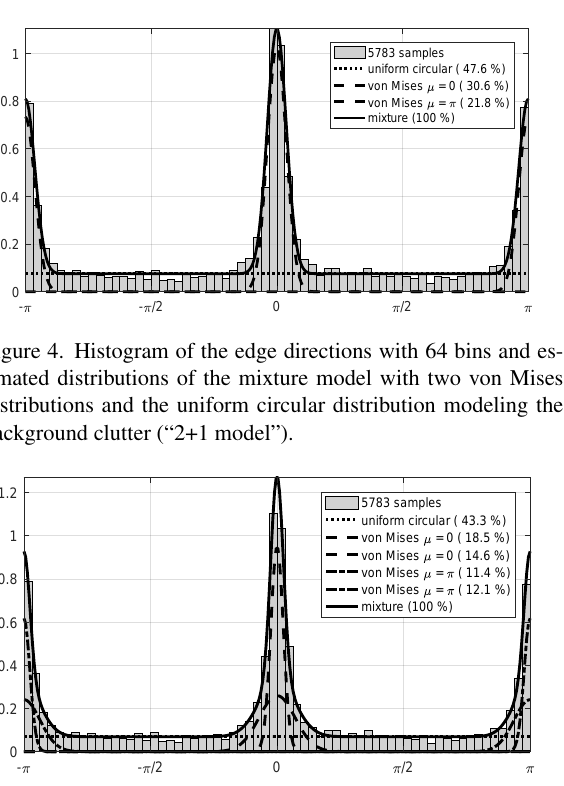
Figure 5. Histogram of the edge directions with 64 bins and es- timated distributions of the mixture model with four von Mises distributions and the uniform circular distribution modeling the background clutter (“2 × 2+1